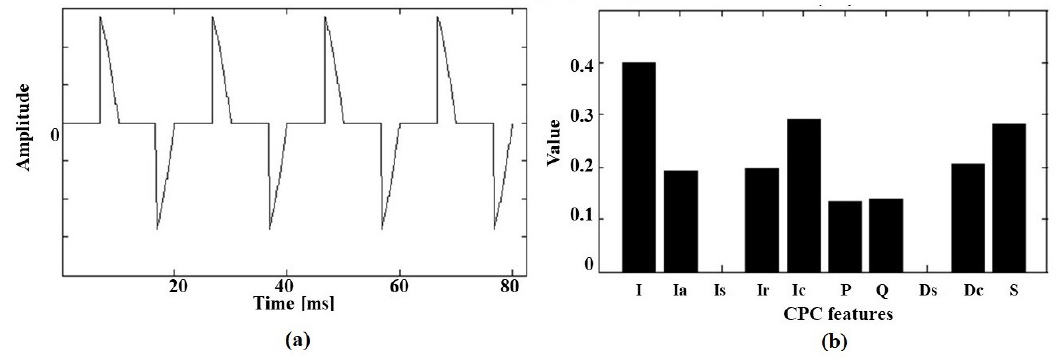
Figure 9. Dimmer with excitation angle of 120 ◦ : ( a ) simulated current waveform; and ( b ) CPC